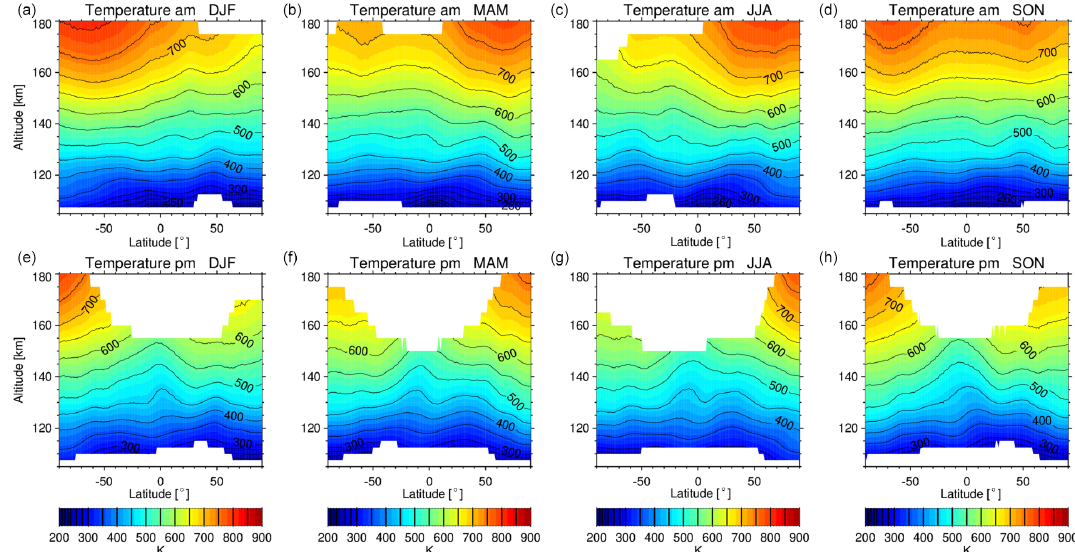
Figure 17. Seasonal composite zonal mean distributions of retrieved temperatures from UA observations as a function of latitude and altitude, separated for morning (a–d) and afternoon (e–h) . Left to right: DJF, MAM, JJA, SON. White areas indicate data with insignificant information content (AK diagonal < 0.03).